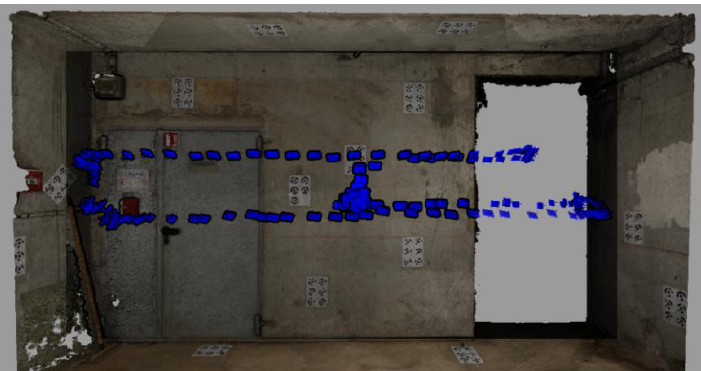
Figure 4. Typical self-calibrating network for the each GoPro